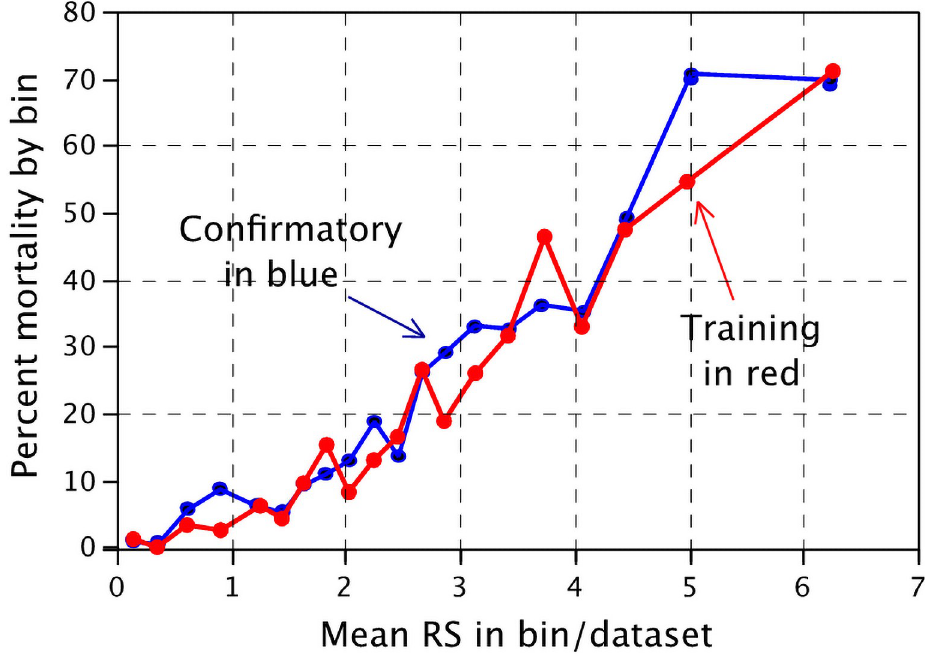
Fig 2. 40-day mortality based on risk score. 40-day mortality among COVID-19 patients in the training and confirmatory sets as divided into bins of 20 patients of ascending mean Risk Scores. Bins 6, 11, and 16 contain 157 patients each and all other bins have 156